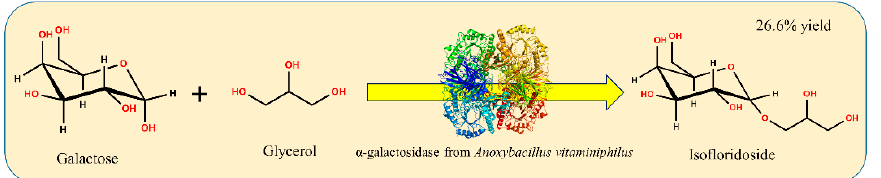
Figure 1. Synthesis of isofloridoside from galactose and glycerol by reverse hydrolysis catalyzed by galV.